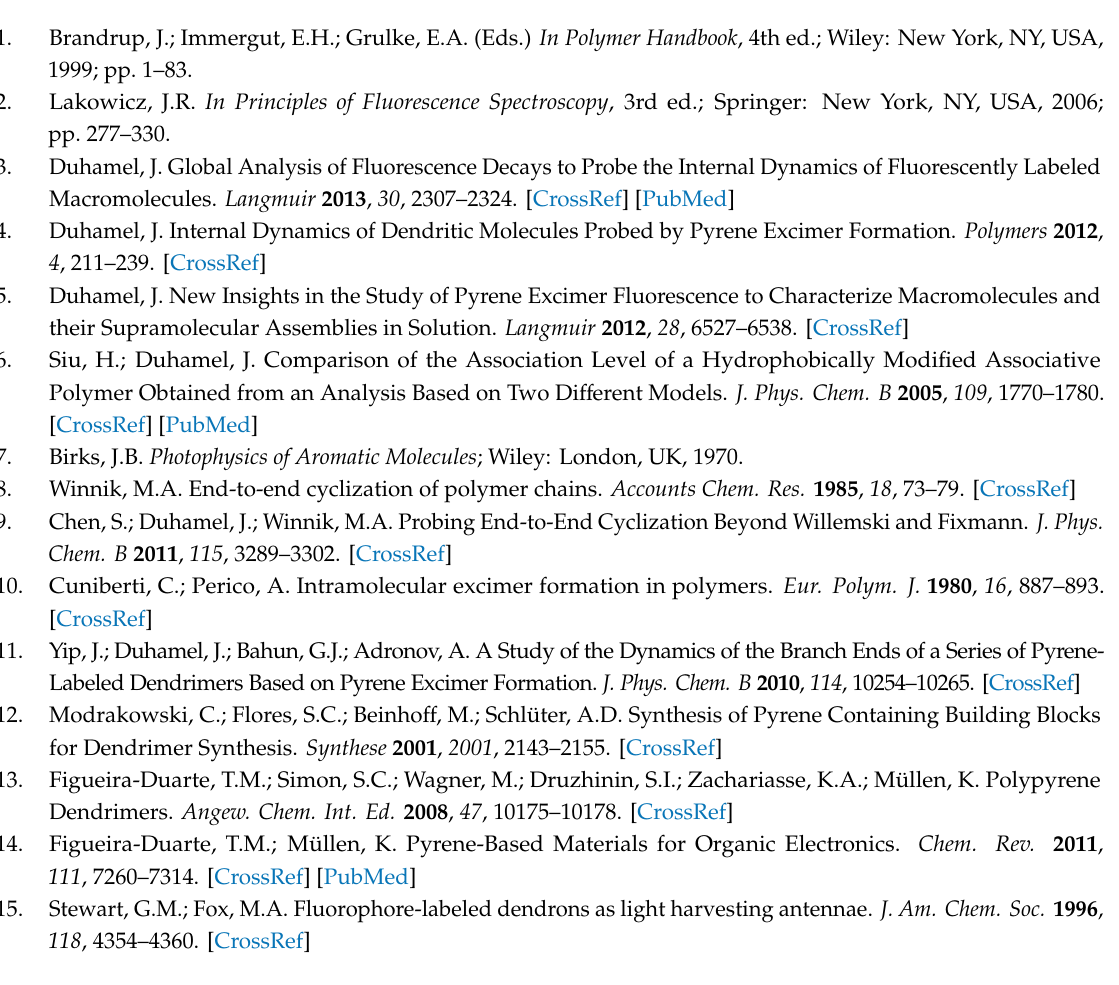
Figure 2. Plot of the I E / I M ratios for each Py x -G( N ) dendron in ( ) toluene, ( ) tetrahydrofuran (THF) [29], ( ) DMF, and ( ) DMSO versus ( a ) generation number and ( b ) the [ Py ] loc .